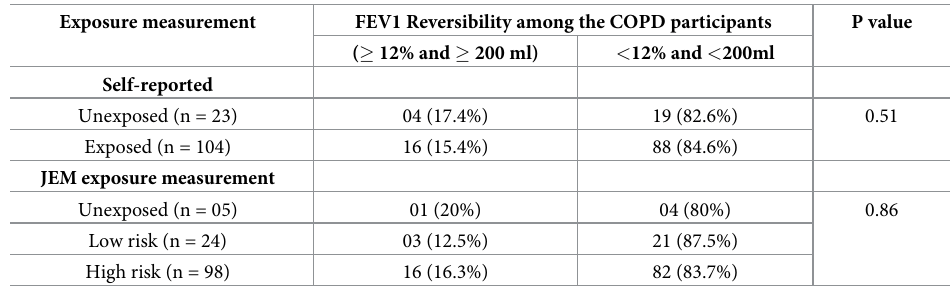
Table 5. Bronchodilator response among the COPD